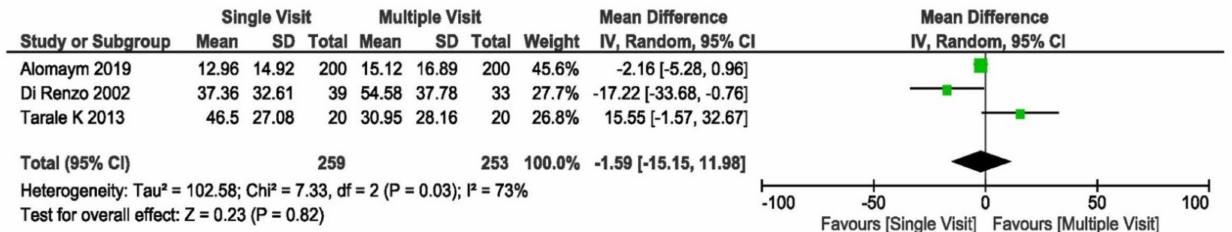
Figure 3. Meta-analysis summarizing the comparison of the intensity of postendodontic pain and flareup between single and multiple visit RCT as measured by the standard visual analogue scale (VAS) with a pain scale of 1 to 10.